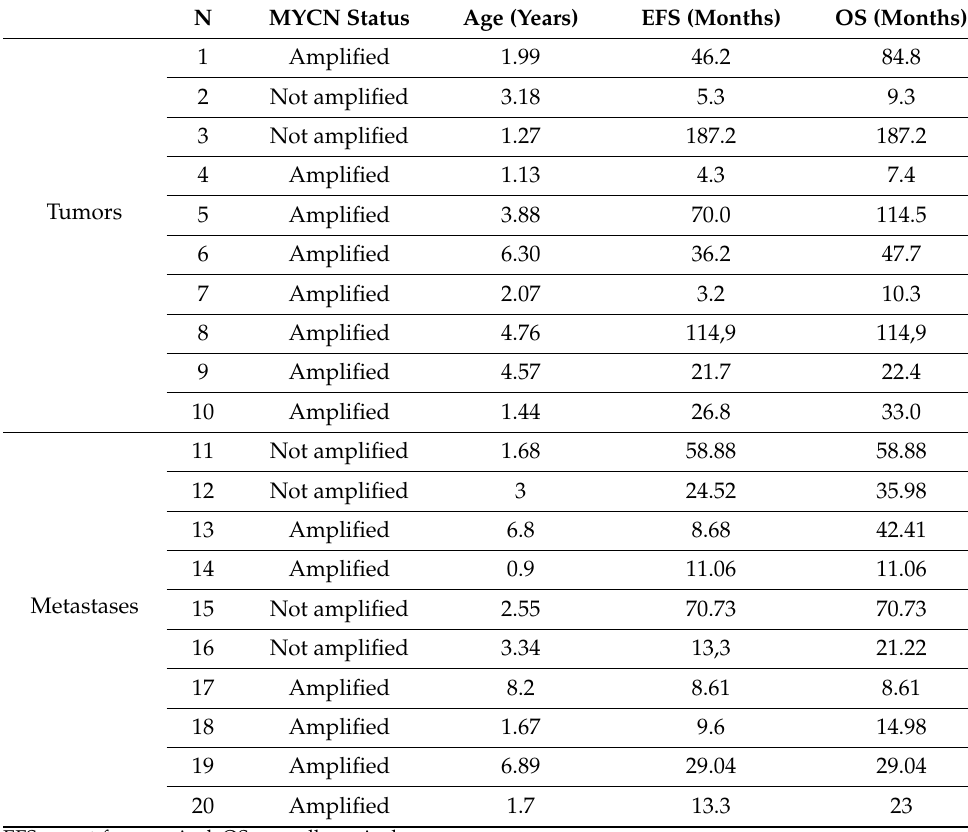
Table 4. Features of NB primary tumors and metastases and patients’ clinical outcomes. N MYCN Status Age (Years) EFS (Months) OS